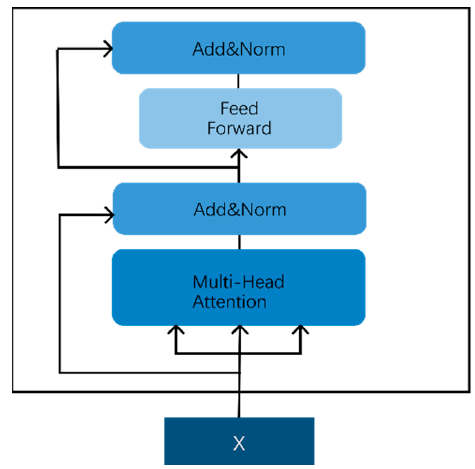
Figure 3. Transformer structure.